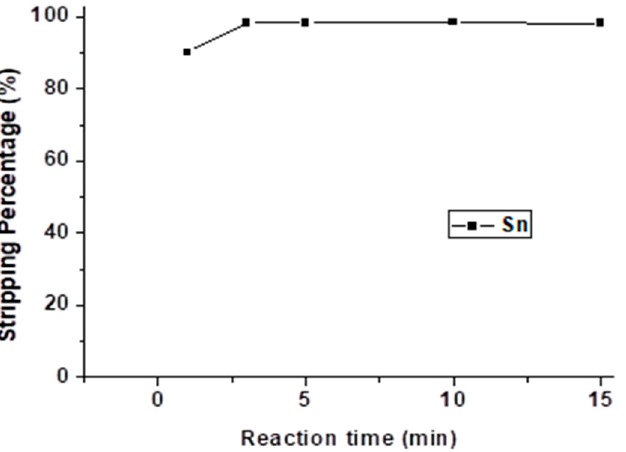
Figure 12. Stripping percentage of Sn at different reaction times. (HNO 3 ) =4 M, O/A ratio = 0.5.